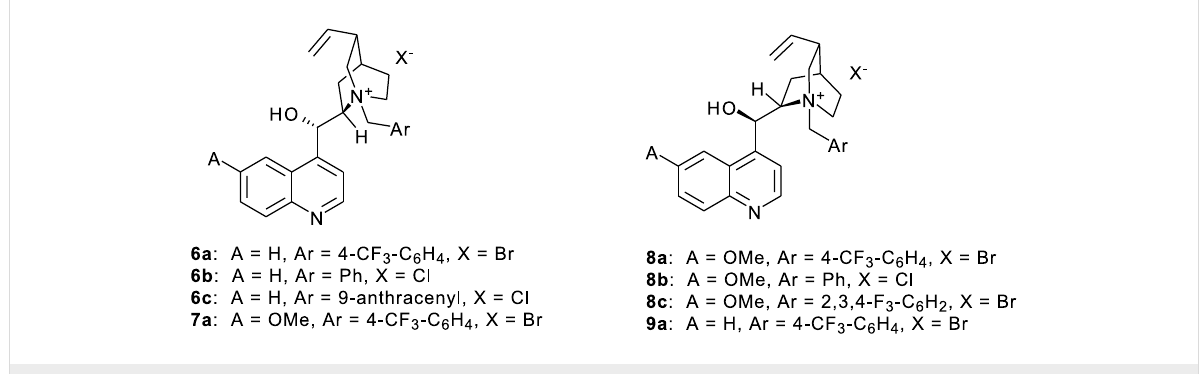
Scheme 1: Structure of chiral quaternary ammonium